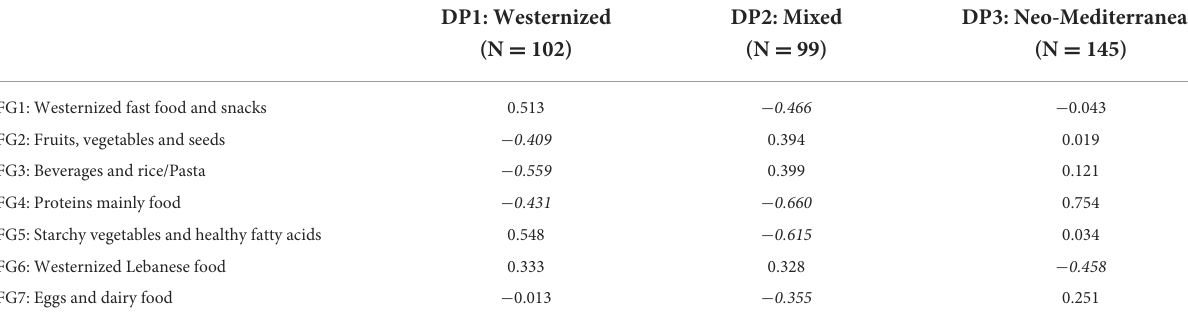
TABLE 4 Dietary patterns: cluster analysis of food groups (N =